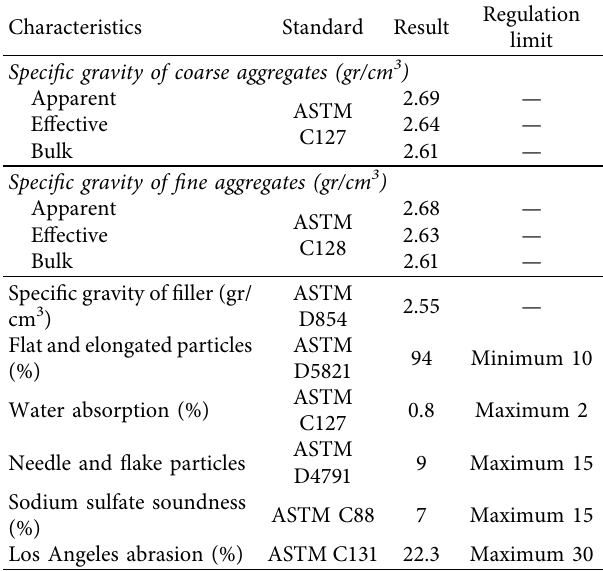
Figure 1: Applied gradation of aggregates. Table 2: Physical characteristics of